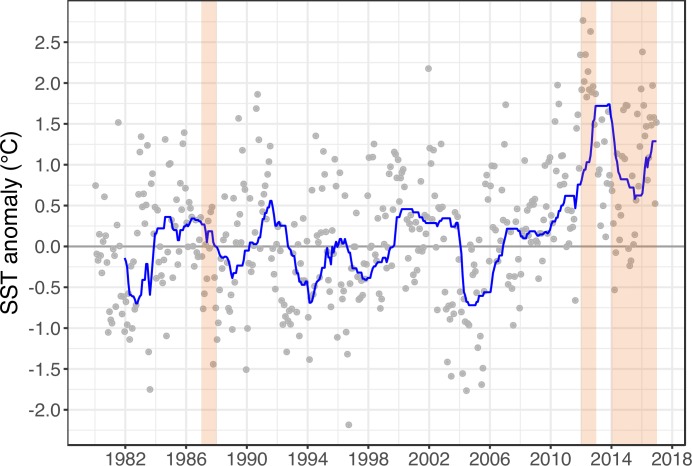
Sea surface temperature (SST) anomalies for the Gulf of Maine between 1980 and 2016.Data were compiled from the Met Office Hadley Centre data set (HadISST). Orange shaded bars correspond to the years that kelp forest communities were sampled on Cashes Ledge. Note that SST anomalies were consistently positive from late 2006 to 2016, and that a record 2.75° C warm anomaly occurred in 2012. A trend line (blue) was fit across the time series using a rolling function based on the median anomaly using a 24-month window with the R program stat_rollapplyr(). Grey dots represent individual SST anomaly data points.